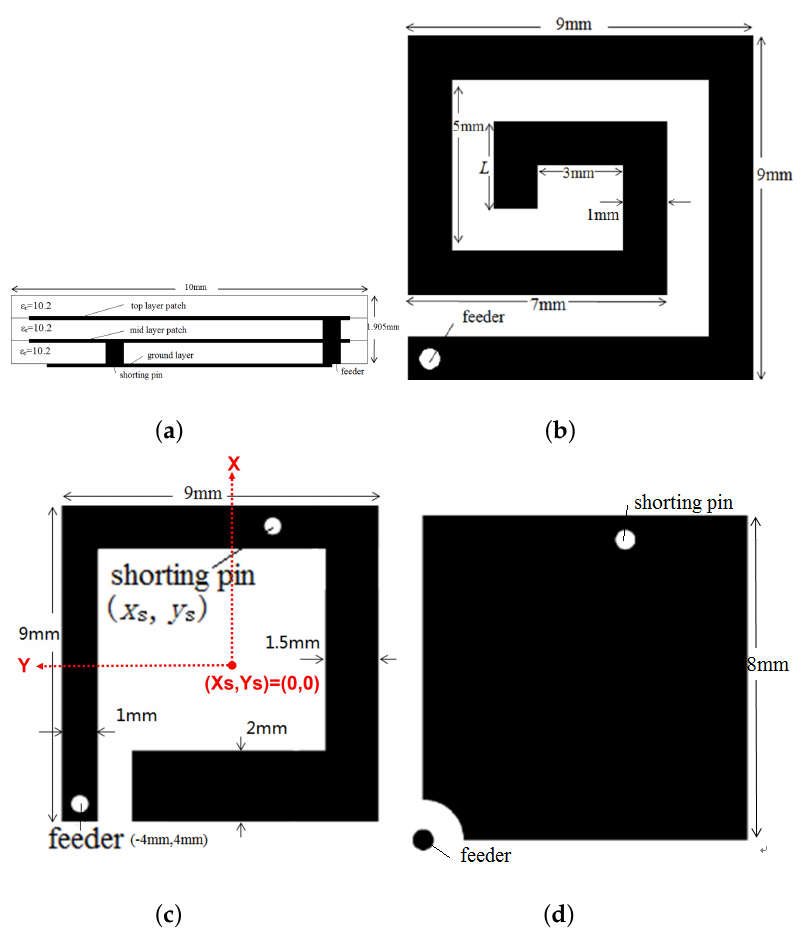
Figure 1. Antenna configuration. ( a ) From the side view, from the top view of ( b ) the top layer, ( c ) the middle layer, and ( d ) the ground layer. All the units are in